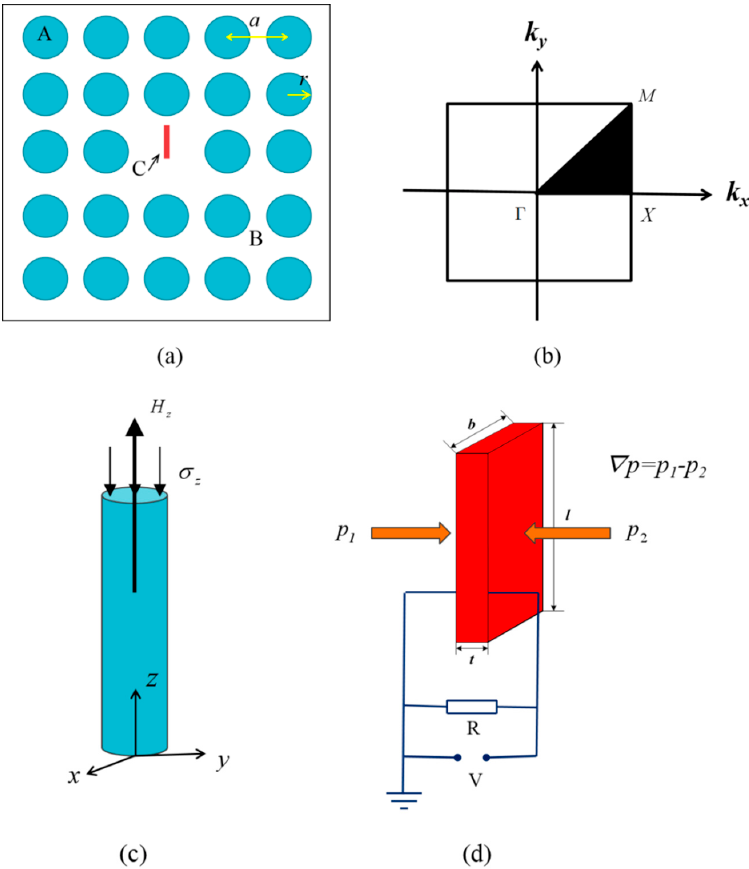
Figure 1. ( a ) Schematic of a 5 × 5 defected supercell of a 2D magneto-elastic PC with a piezoelectric patch. ( b ) The first irreducible Brillouin zone (triangular area Γ − X − M − Γ ). ( c ) The Terfenol-D rod is affected by applied pre-stress and the magnetic field. ( d ) The structure and circuit connection of a piezoelectric